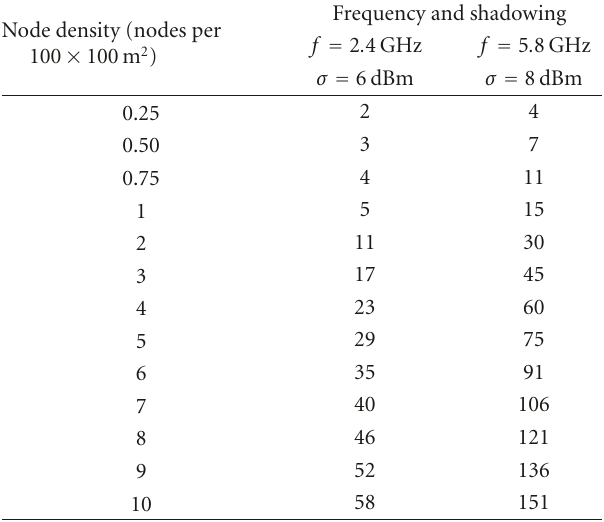
Figure 1: Example of relative span weights.